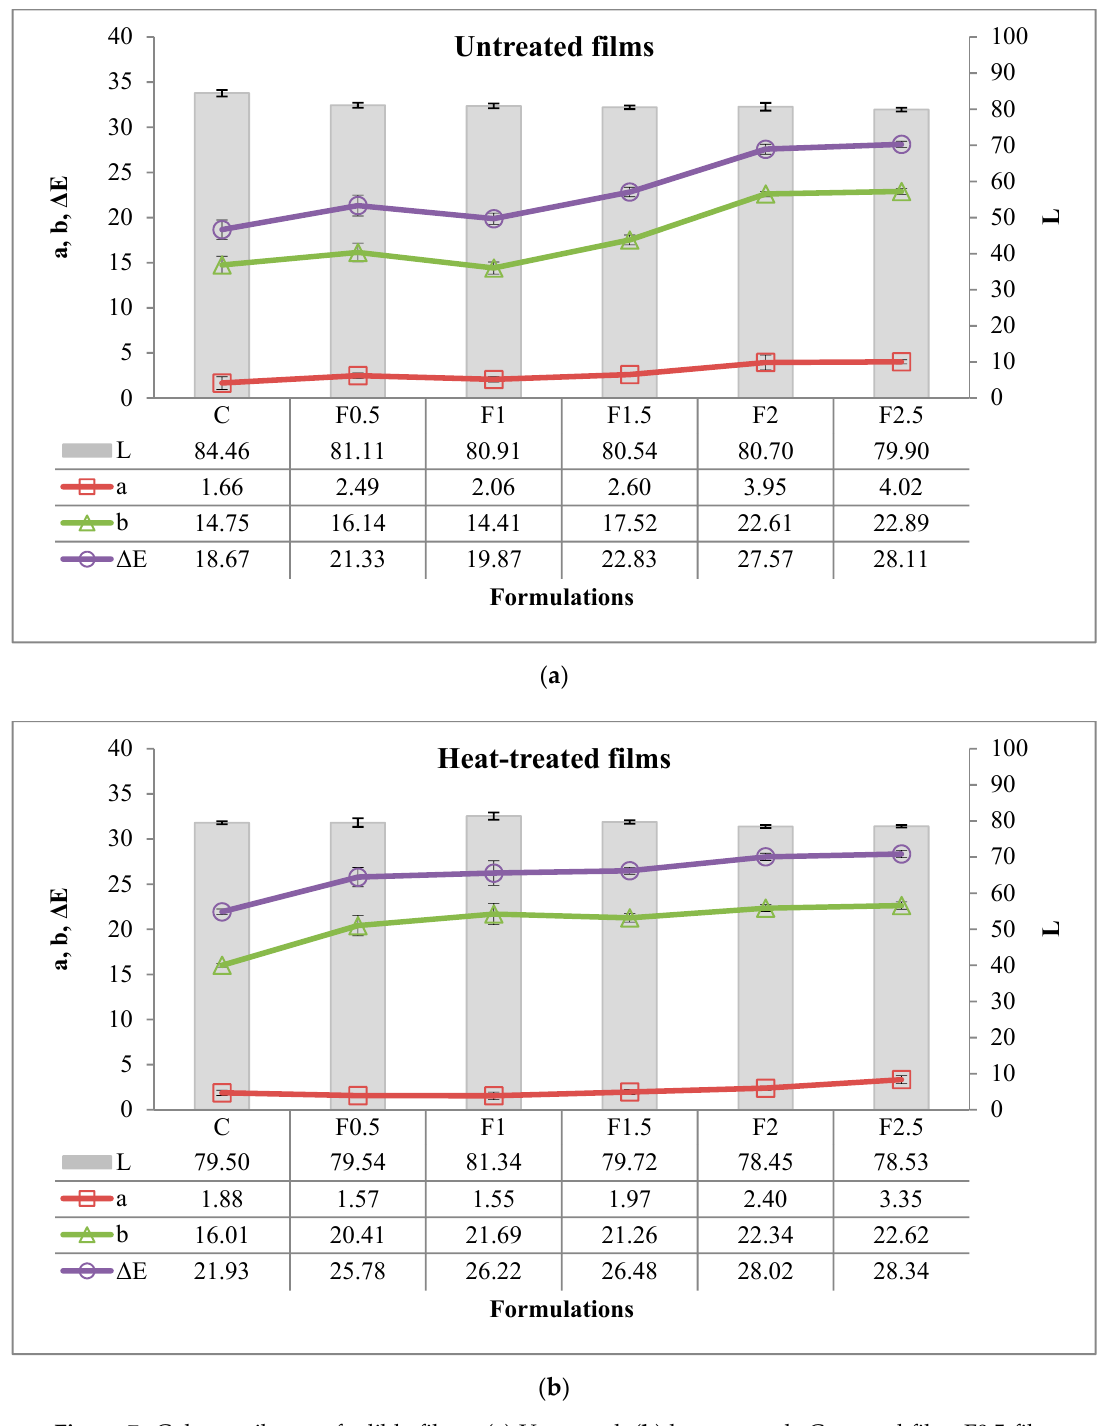
Figure 7. Color attributes of edible films. ( a ) Untreated, ( b ) heat-treated. C-control film; F0.5-film with 0.5% tarragon essential oil; F1-film with 1% tarragon essential oil; F1.5-film with 1.5% tarragon essential oil; F2-film with 2% tarragon essential oil; F2.5-film with 2.5% tarragon essential oil. Values are expressed as mean ± standard deviation of 12 replicates.